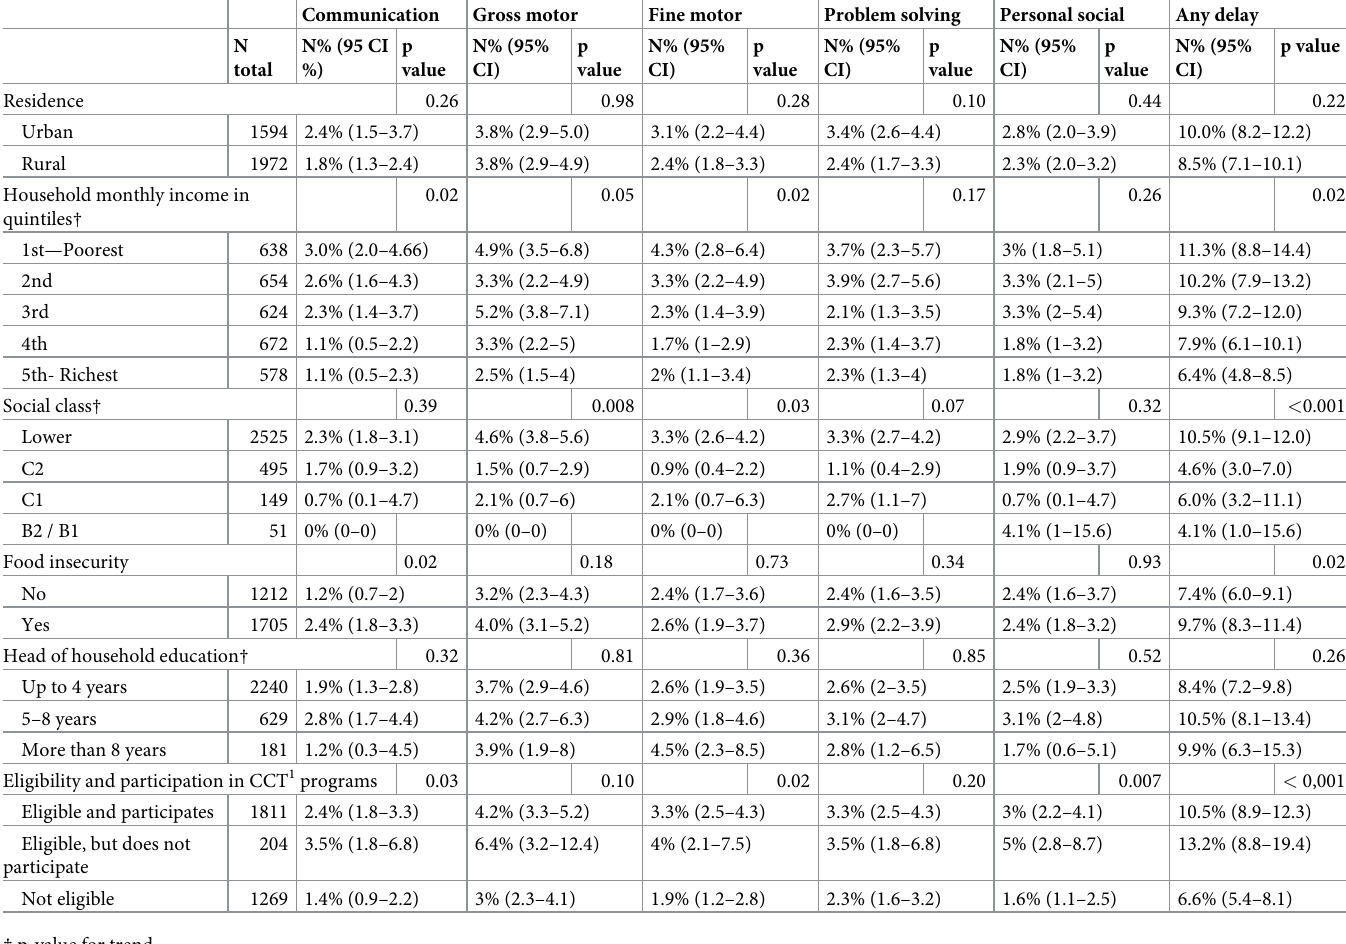
Table 4. Prevalence of child development delay by domain stratified by socioeconomic factors.